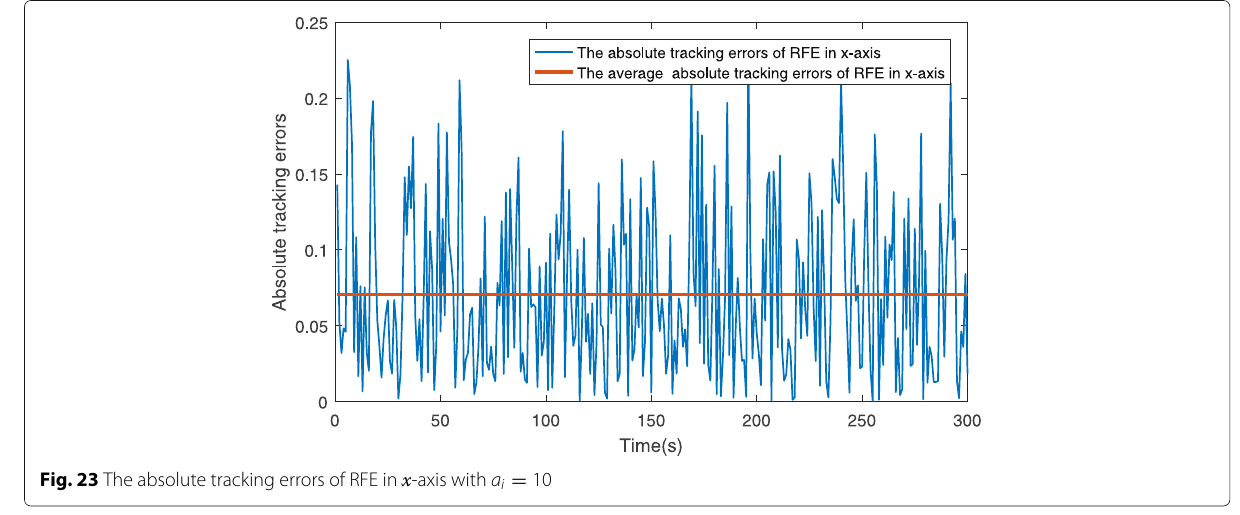
Fig. 23 The absolute tracking errors of RFE in x -axis with a i = 10